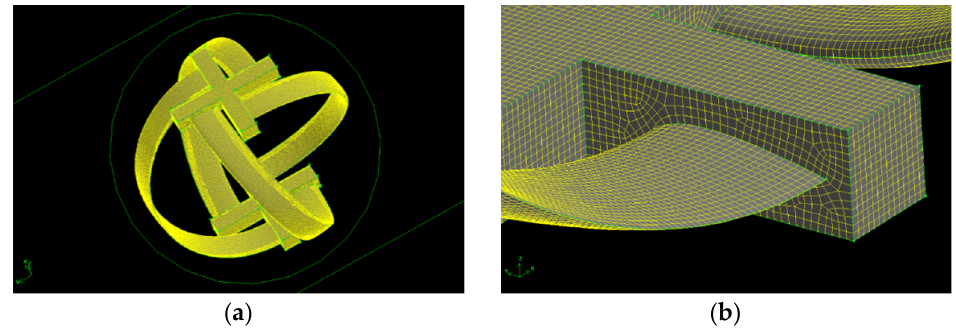
Figure 11. ( a ) Mesh of the turbine and surrounding space around the turbine; ( b ) mesh of a single blade of the turbine; ( c ) static mesh of fluid around turbine in lateral view; ( d ) static mesh of fluid around turbine in top view.